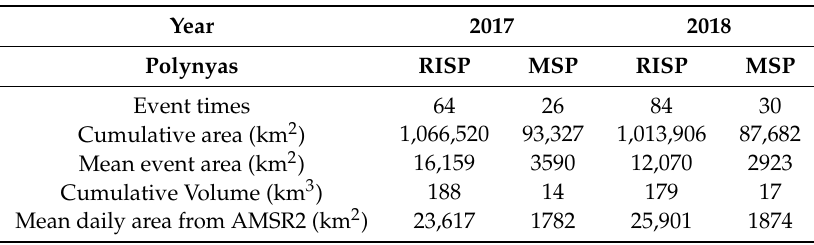
Table 2. Statistics of wind–driven polynya ice production events in the Ross Ice Shelf polynya (RISP) and McMurdo Sound polynya (MSP) during 2017 and 2018. The mean ice production event areas derived from AMSR-2 (ice thickness < 20 cm) are also included for